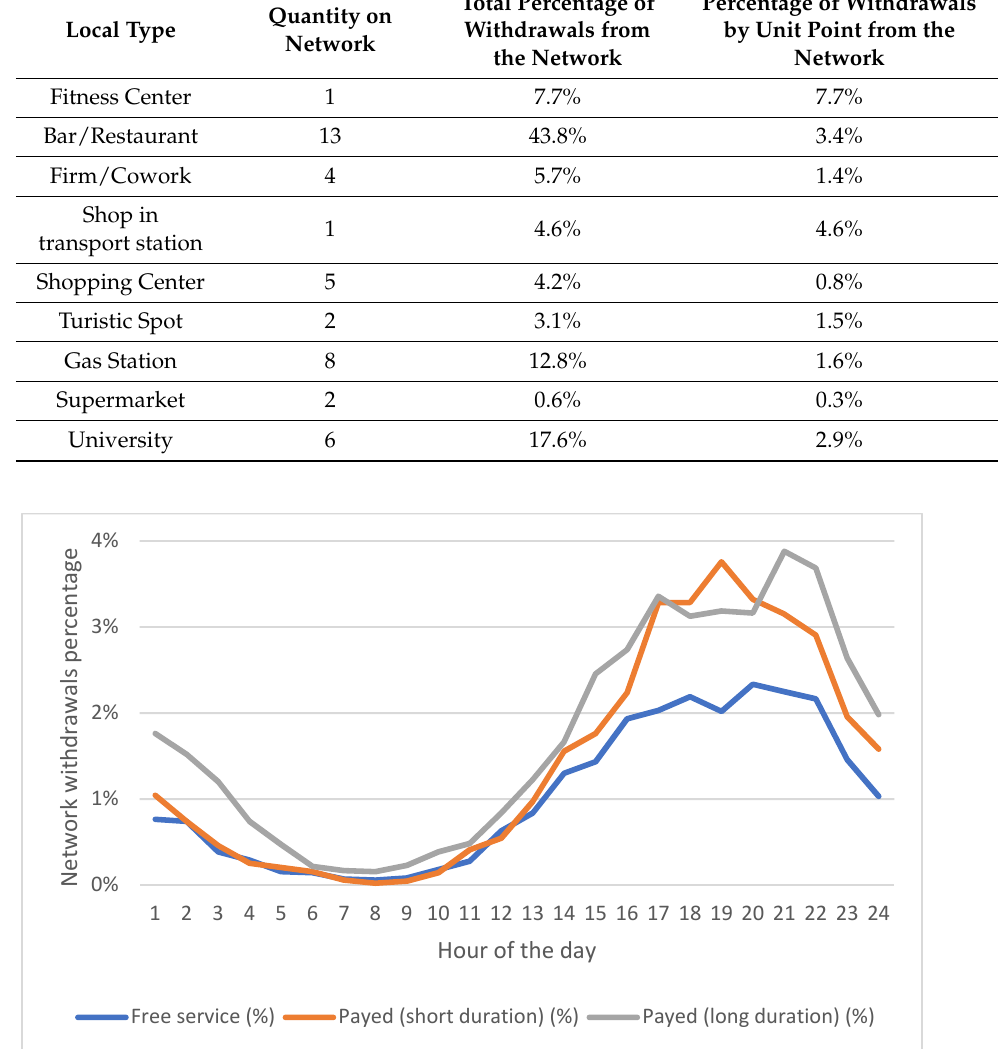
Figure 3. Average charge capacity for each battery group.